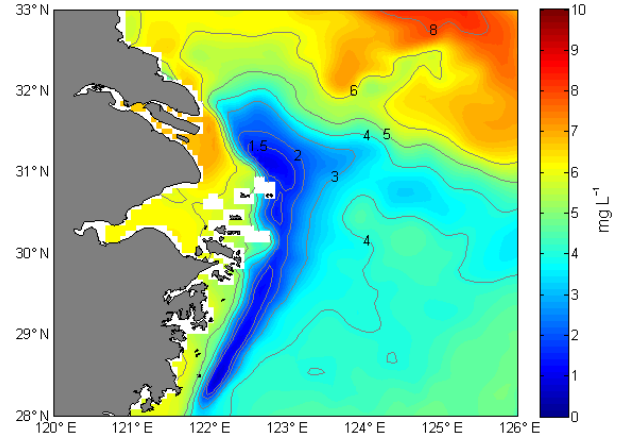
Figure 7. The modeled patterns of hypoxic zone off the Yangtze Estuary in September